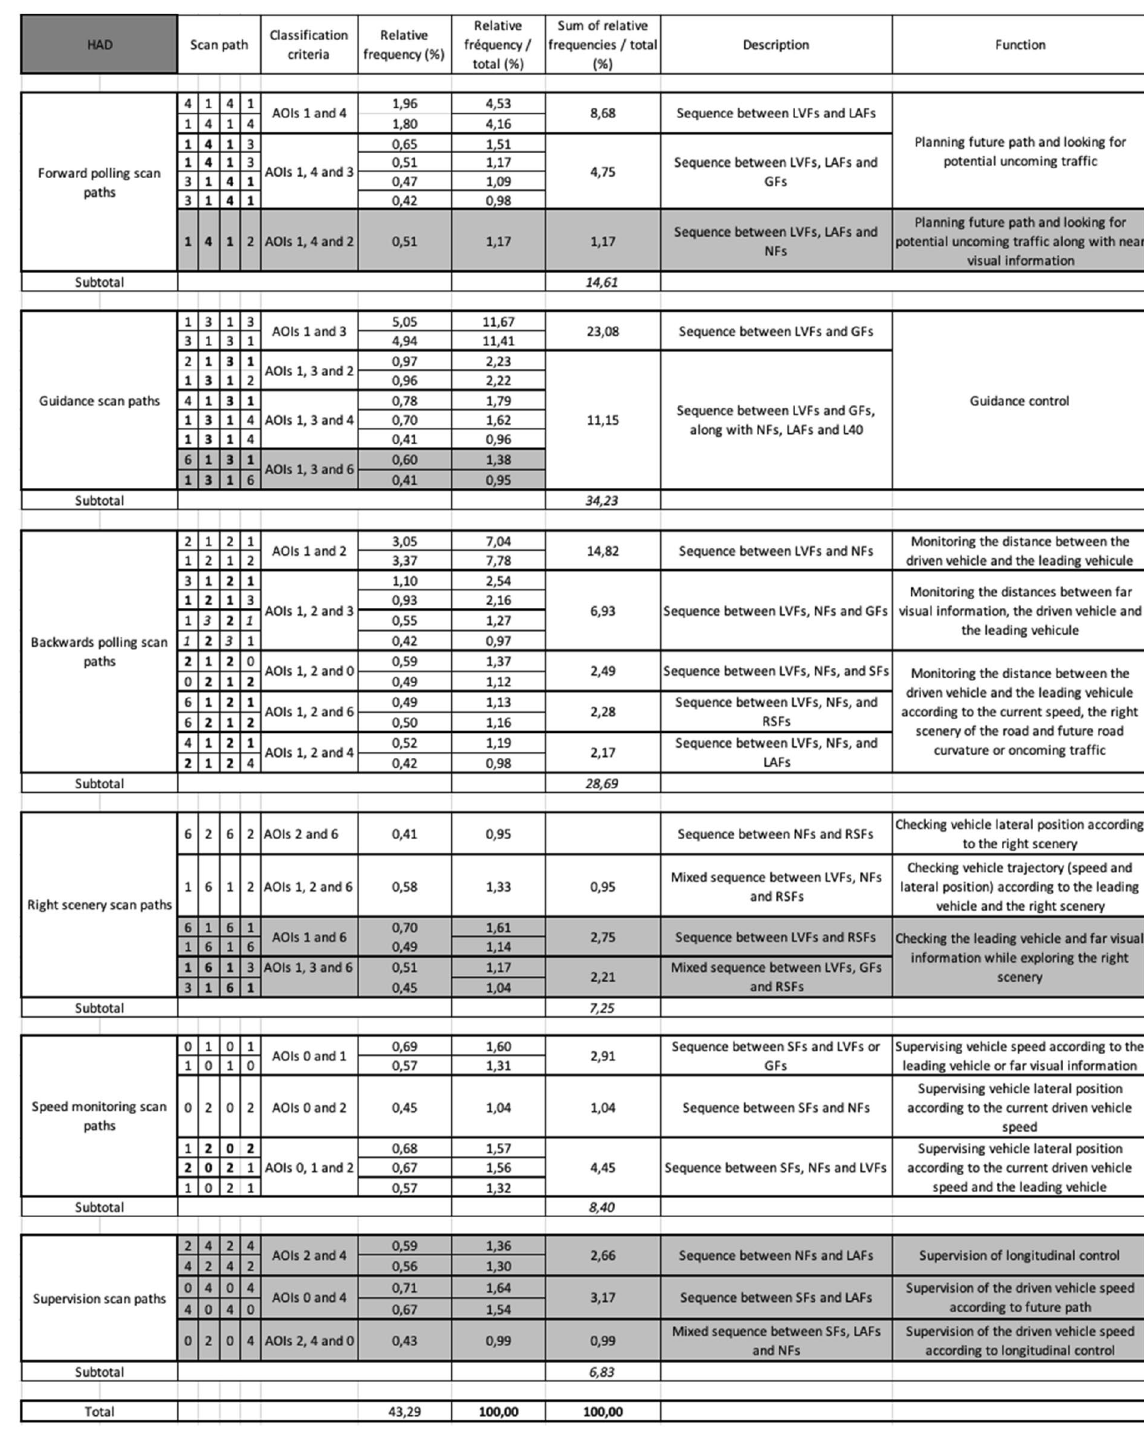
Table 2. The forty-five most frequent scan paths (length 4) out of the 634 scan paths observed in Highly Automated Driving (HAD). Given are each scan path relative frequency (%) in the entire dataset, and relative frequency for the subset of the 45 scan paths analyzed (%) along with a description of the associated visual sequence and proposed functional interpretations. Scan paths in grey were not observed under Manual Driving (MD). LVFs: Leading Vehicle Fixations; RSFs: Right Scenery Fixations; SFs: Speedometer Fixations; GFs: Guiding Fixations; LAFs: Look Ahead Fixations; NFs: Near